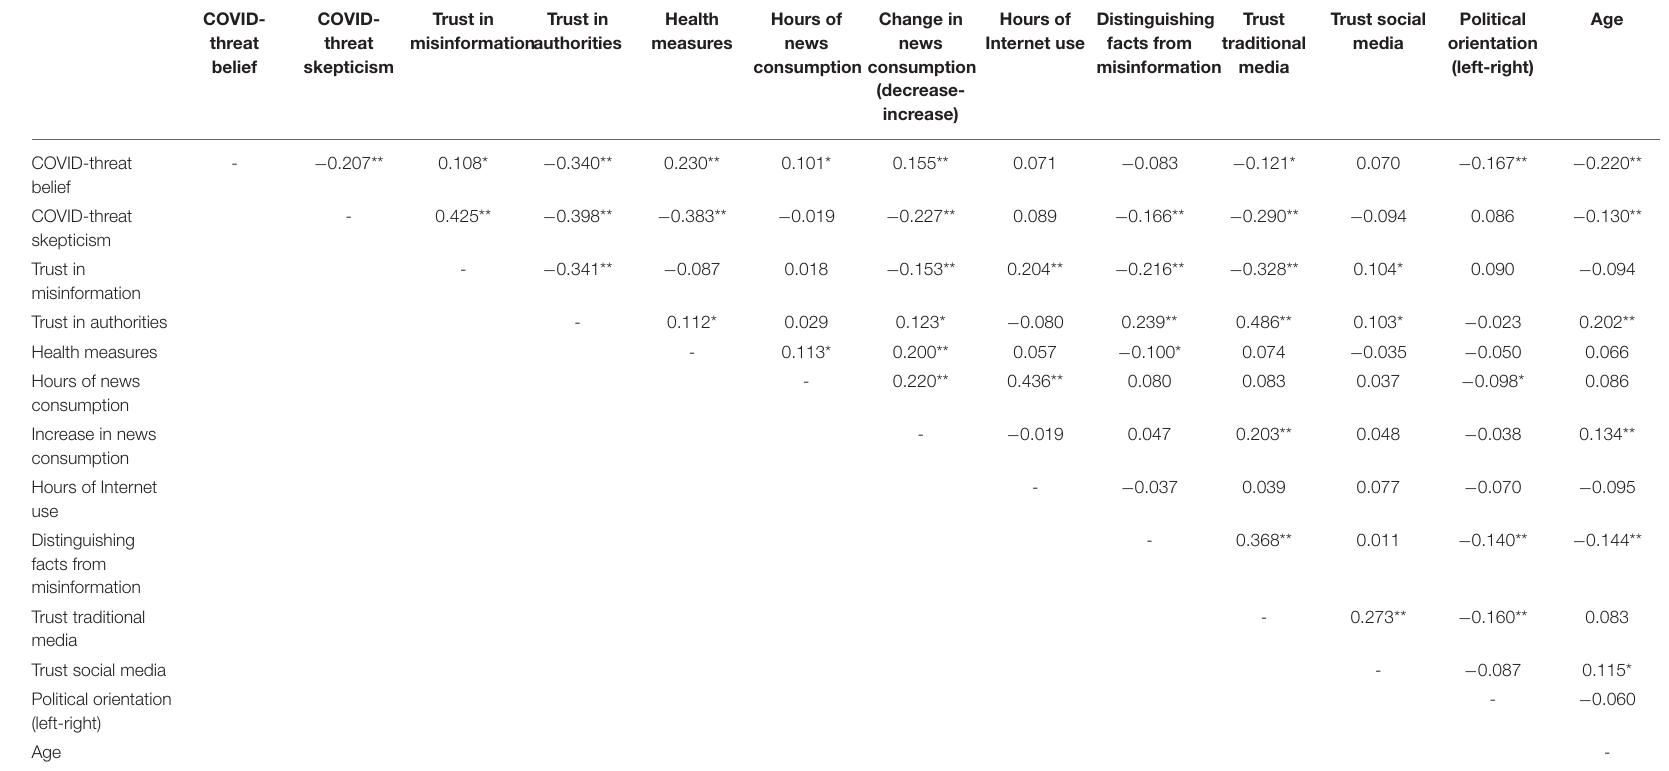
TABLE 2 | Associations between beliefs about COVID-19, precautionary behavior and media consumption. COVID-